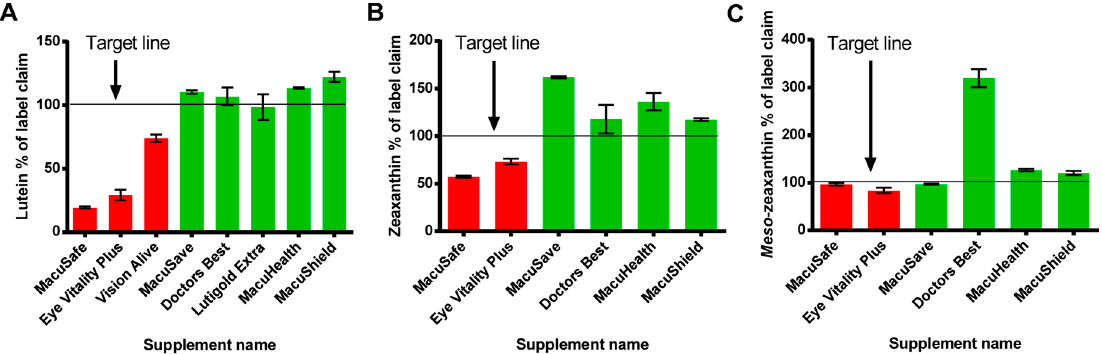
Figure 3. Initial time point analysis illustrating concentration of L ( A ) Z ( B ) and MZ ( C ) expressed as a % of label claim for each product analysed (powder filled capsules are in red, oil filled capsules are in green). Vision Alive and Lutigold products are not shown in ( B ) and ( C ), as these products made no label claim regarding the concentration of Z and MZ. All supplements were analysed in triplicate.